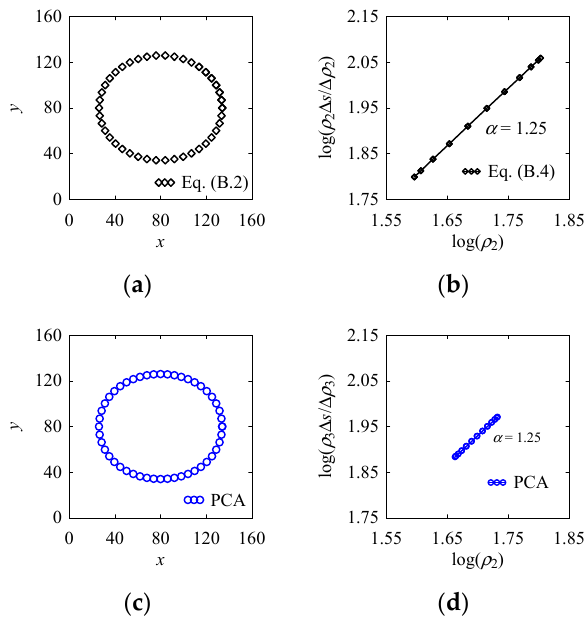
Figure 14. Logarithm curvature histogram (LCH) of ellipses. ( a ) Point cloud of an ellipse modeled by a parametric-based equation; ( b ) LCH of (a); ( c ) point cloud of an ellipse modeled by the PCA; ( d ) LCH of (c).